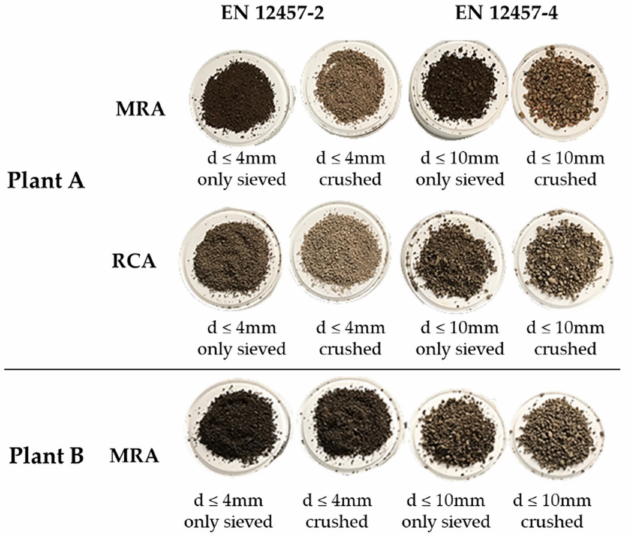
Figure 4. Samples of RAs subjected to leaching tests according to EN 12457-2 and 4